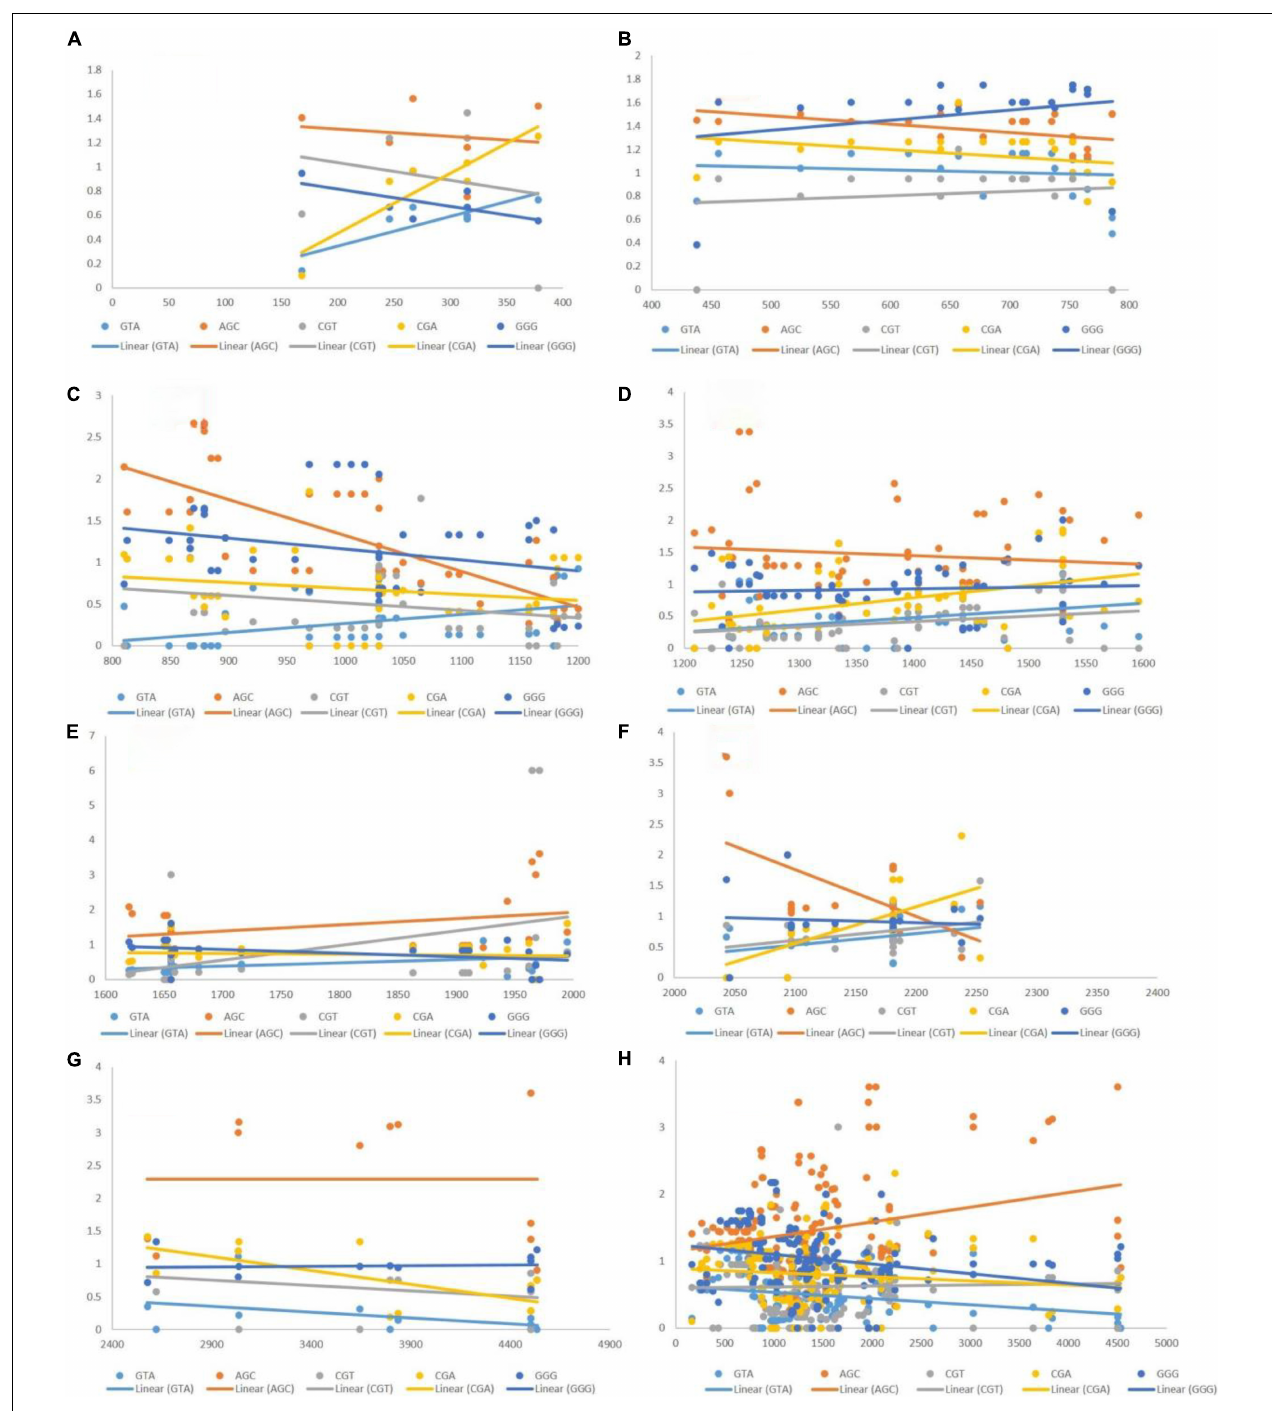
FIGURE 6 | Regression analysis of RSCU values of codons (positively associated with gene length) with gene segments of various lengths. Each dot represents a codon. The trend line is depicted as a solid line, and color coding for each codon and trend line is given inside the figure. (A) 1–400 bp; (B) 400–800 bp;